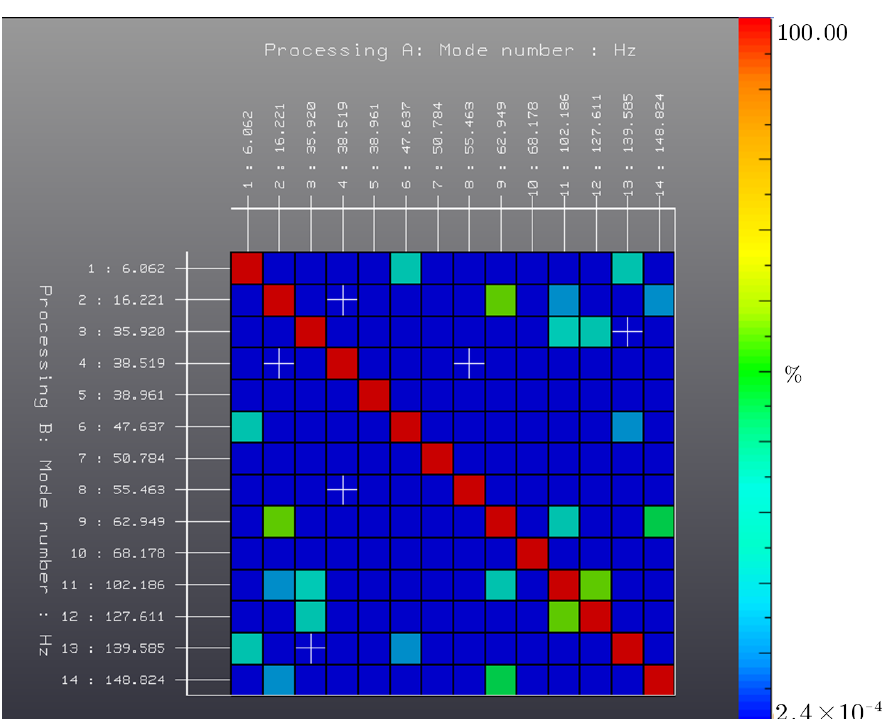
Figure 6. The modal assurance criterion plot of 14 modes of the GARTEUR model in our modal experiment. Modal data between 6.062 Hz (mode 1) to 140.024 Hz (mode 14) of the GARTEUR aircraft model are obtained. The sampling frequency is set to 2048 Hz, which is more than 10 times that of mode